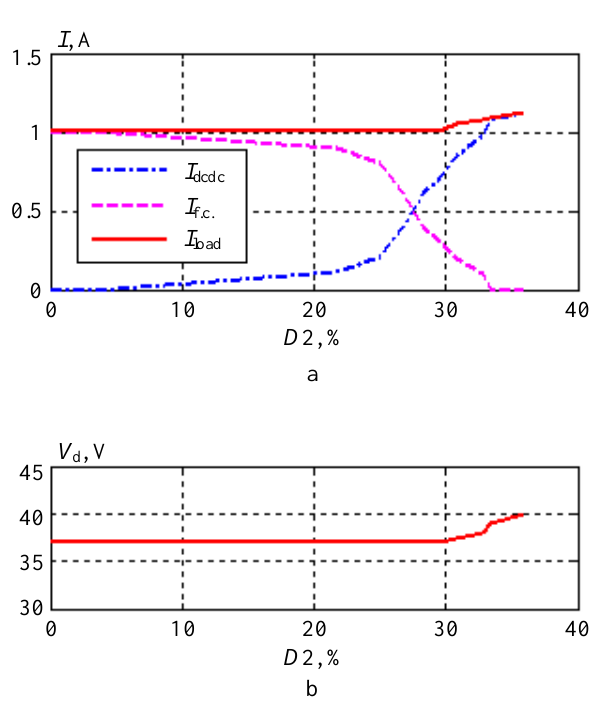
Fig. 9. Currents (a) and DC bus voltage (b) depending on the DC-DC converter duty ratio D 2 in the boost mode at the 30 V DC converter’s input